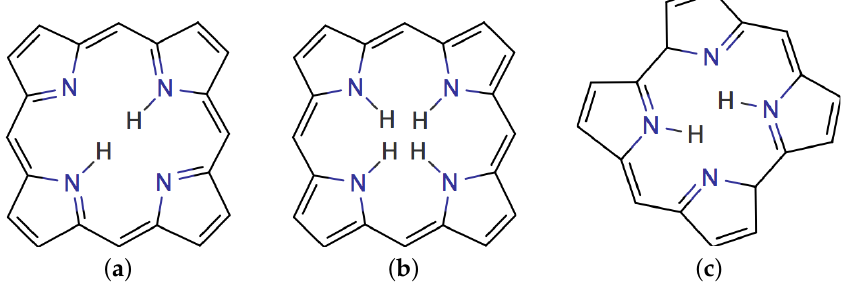
Figure 2. The molecular structure of ( a ) free-base trans -porphyrin, ( b ) free-base isophlorin, and ( c ) free-base trans